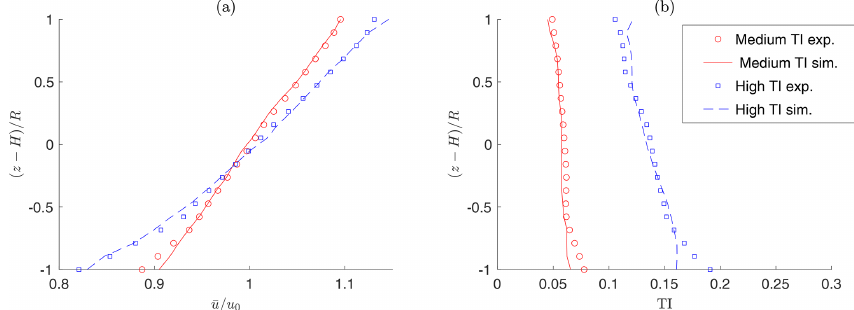
Figure 7. Mean velocity (a) and turbulence intensity (b) distributions along a vertical line 3.59 D in front of the